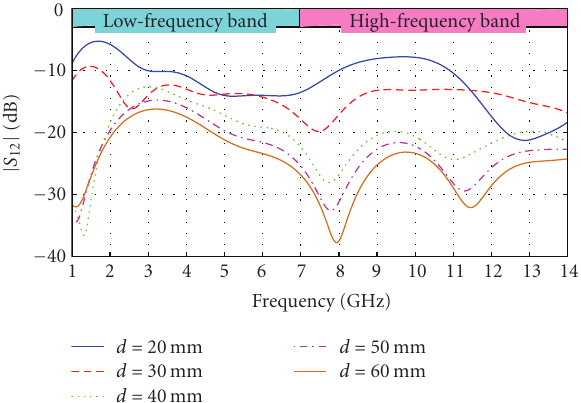
Figure 5: Simulated | S 12 | results of two-element UWB array.